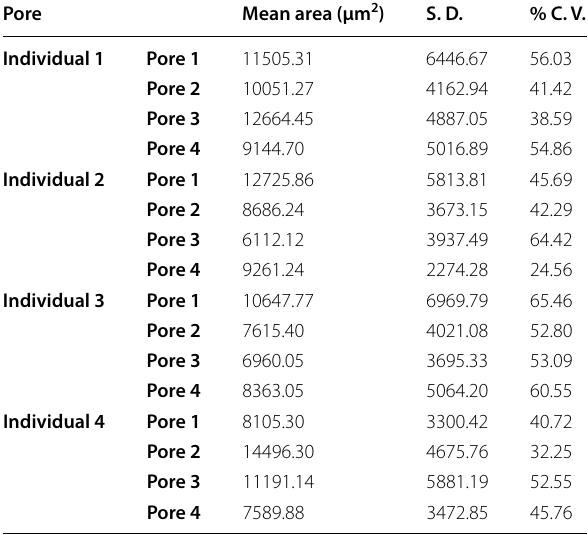
Table 2 Mean area, standard deviation (S. D.), and % coefficient of variation (% C.V.) of four pores, taken from fingerprints obtained from the right index finger of four individuals on sticky side of adhesive tape (using method (ii)), recorded on ten consecutive days, show % C. V. to be beyond the normal acceptable level (with 5% confidence level in analytical work), thereby demonstrating that pore area is not a reproducible feature for matching fingerprints